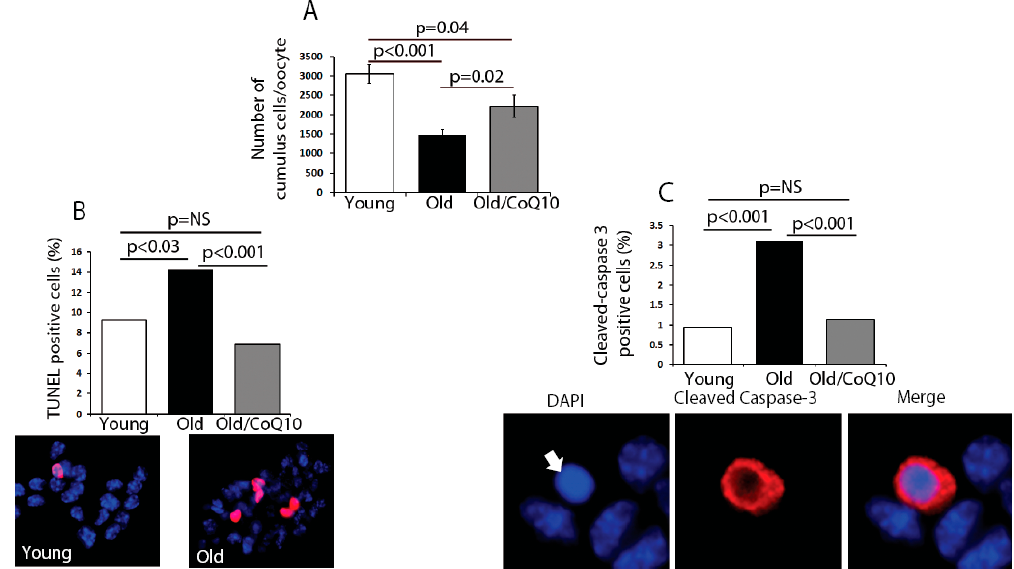
Figure 2. Aging impacts cumulus cell number via regulation of apoptosis. ( A ) Number of cumulus cells per oocyte declined with aging, but this was significantly improved after CoQ10 supplementation. Pooled cumulus cells from the same mouse were counted and divided by the number of ovulated oocytes, per female, to obtain the number of cells per oocyte. Values represent mean ± SEM from young ( n = 15), old ( n = 10), and old-CoQ10 mice ( n = 8), per oocyte, per female. ( B ) Proportion of TUNEL and cleaved caspase-3-positive cumulus cells. Approximately 1,000 cells were counted in each category and these were generated by pooling cumulus cells from oocytes from three different females. Increased apoptosis of cumulus cells, with aging, with a protective effect of CoQ10. Representative images are shown below the graph (DAPI—blue, TUNEL—red). ( C ) Proportion of cleaved caspase-3 positive cells in each age category: images below demonstrate apoptotic cumulus cell (arrow), with the picnotic nucleus-stained positive for cleaved caspase-3 obtained from old females, as an example of staining (magnification 400 × ). NS: not significant.